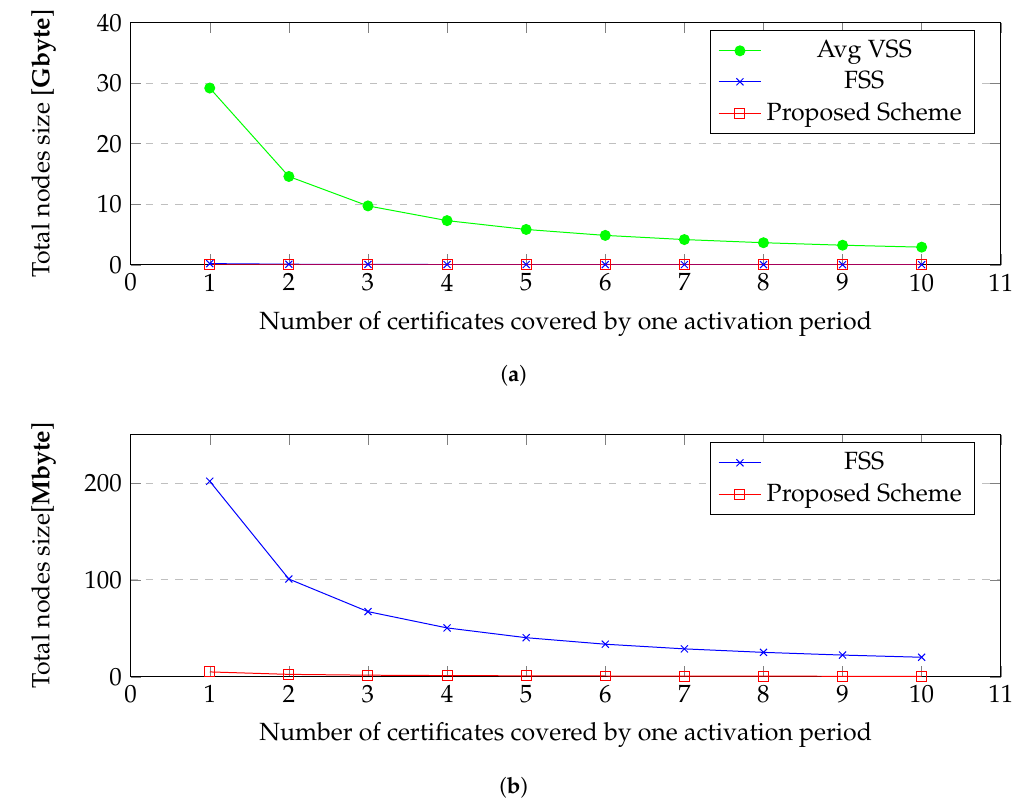
Figure 9. The total amount of downloaded nodes by a vehicle in 3 years. ( a ) Comparison among average VSS, FSS, and proposed scheme. ( b ) Comparison between FSS and proposed